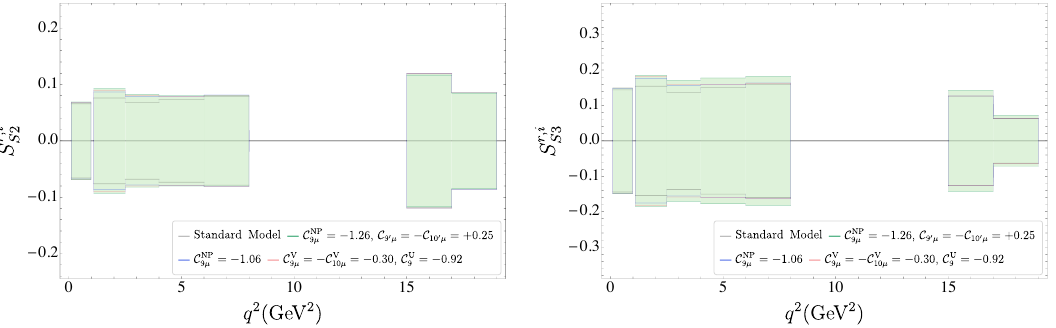
Figure 4 . Illustration of the sensitivity of the central value of the bound to the preferred NP scenarios for two observables S r,i and S r,i . We have checked explicitly that the variation of the S 2 S 3 bound in the most significant NP scenarios amounts to at most a 20-25%